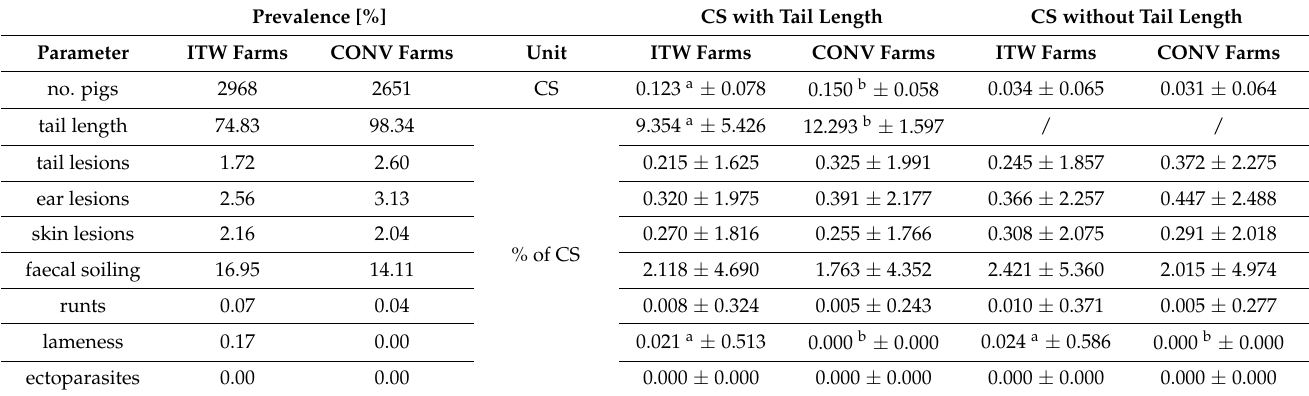
Table 6. Cumulative score of animal-based welfare parameters and parameter distribution in ITW- and CONV-housed pigs according to the KTBL guideline. Data are presented as means ± standard deviation and statistically analysed using PROC GLIMMIX (SAS).